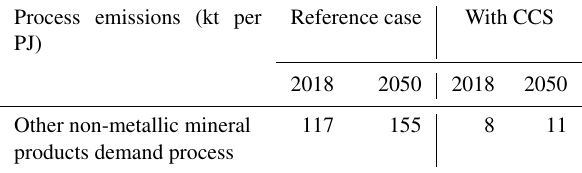
Table 12. Maximum fuel-switching shares.